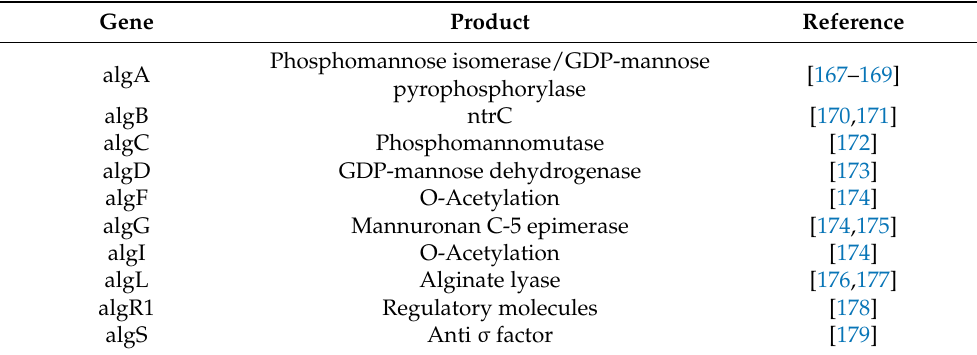
Table 3. Genes involved in the production of alginate by bacteria and their gene